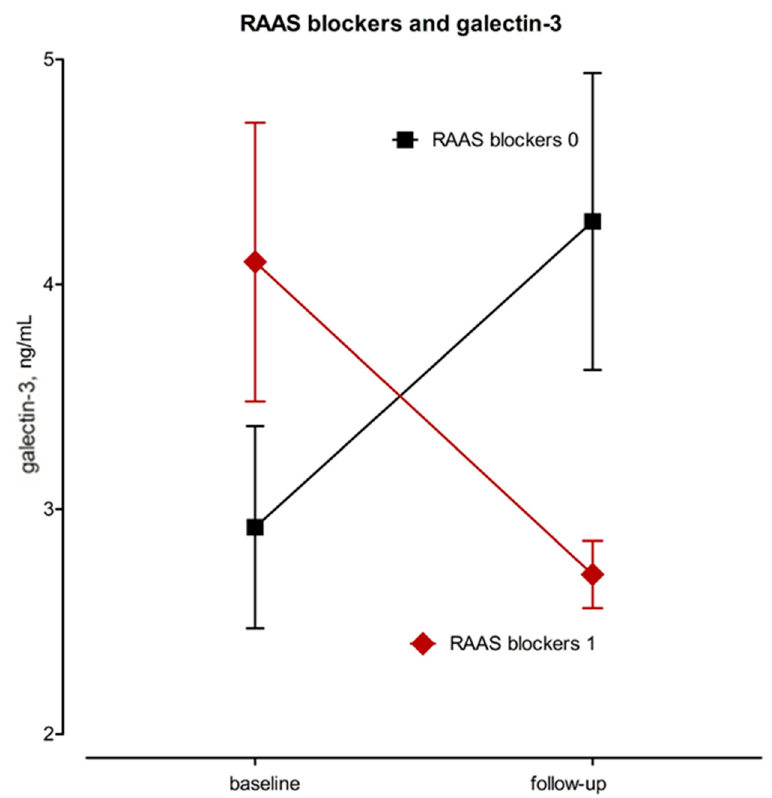
Figure 2. Galectin-3 values according to use of RAAS blockers. Values are means (standard errors of means). RAAS blockers = blockers of renin-angiotensin-aldosterone system.